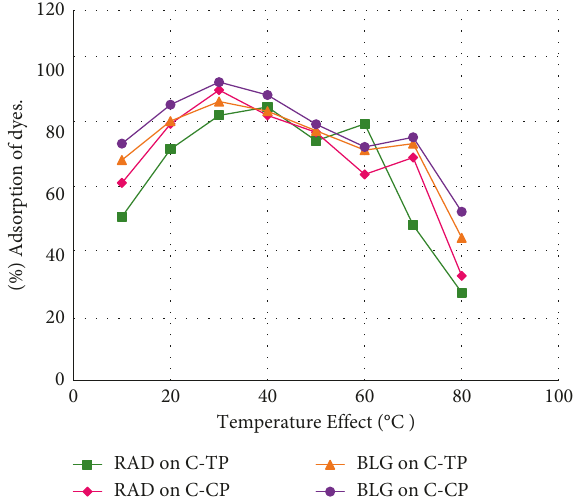
Figure 12: Influence of a change in temperature on biosorption. Initial pH � 5, final pH for RAD on C-TP and C-CP � 4, BLG on C- TP � 4.5, and BLG on C-CP � 4.